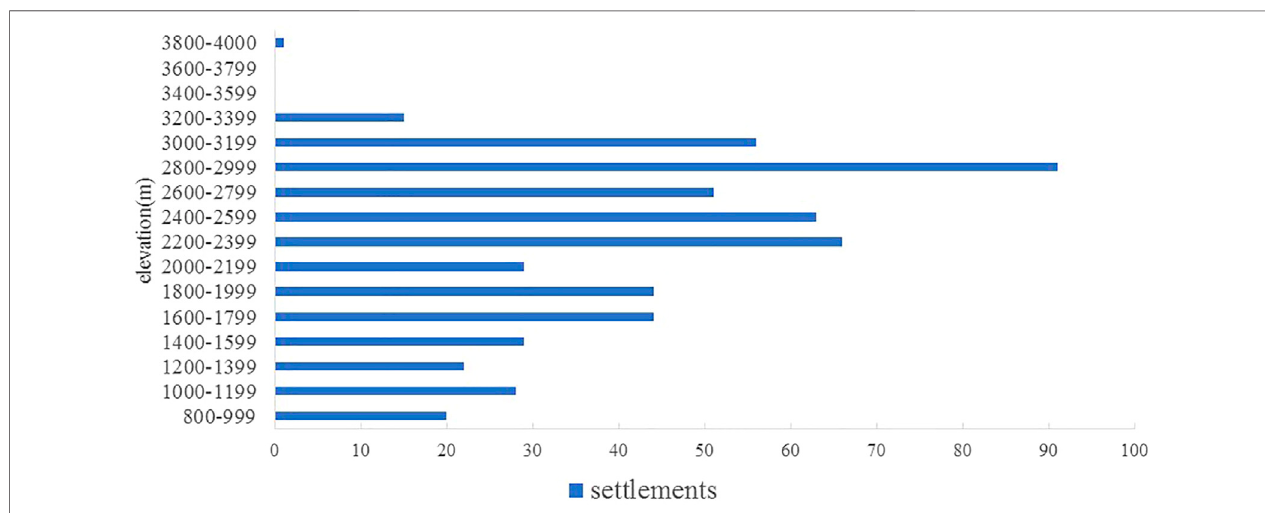
FIGURE 5 | The distribution of settlements by